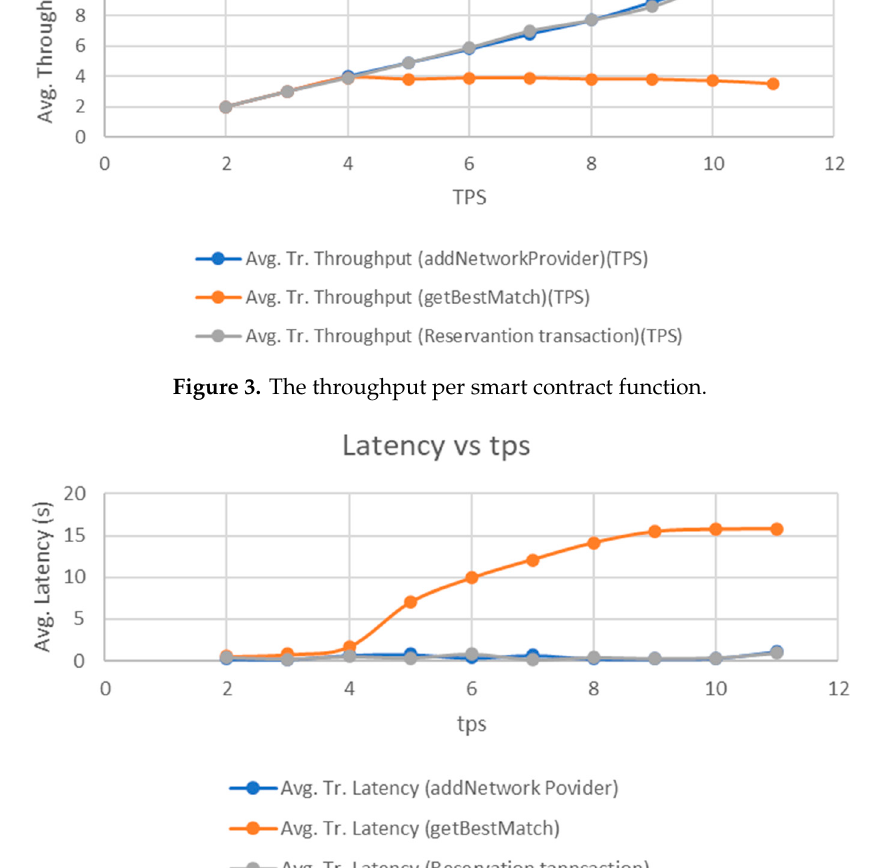
Figure 3. The throughput per smart contract function .